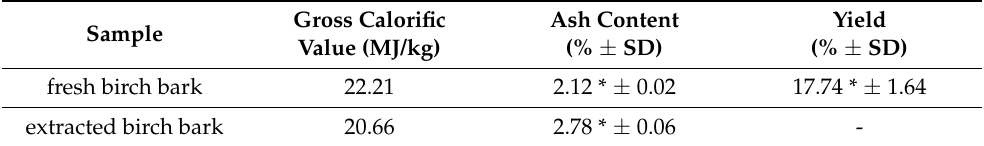
Table 1. Means ( ± standard deviation) of the results of the birch bark before and after extraction.